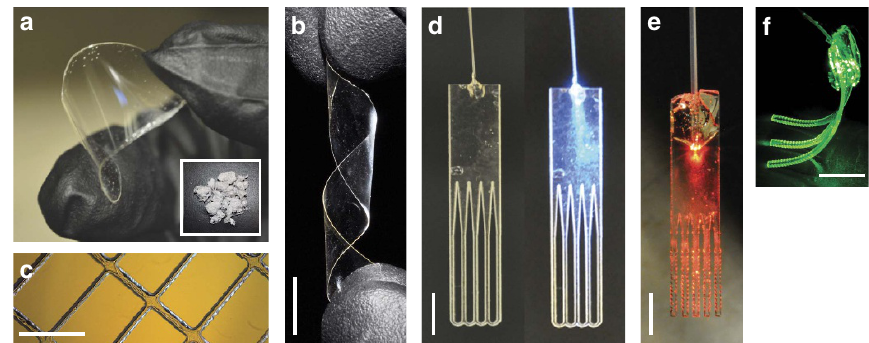
Figure 1 | Various biopolymer films and planar waveguide demonstrations. ( a ) Transparent and flexible poly( L -lactic acid) biopolymer film obtained by melt-pressing technique. Inset: biopolymers in their initial powder form before film formation. ( b ) A twisted bio-film before laser cutting. ( c ) Laser cutting allows for a simple fabrication of films with well-controlled meshes. ( d ) A fibre-coupled waveguide array with an unstructured top region uniformly coupling the light to the array of thin waveguides. Left, off state; right, light on. Only the lower part of the devices is to be embedded into tissue, the top structure including the pigtail fibre is cut off and removed after use. ( e ) Red light coupled to a waveguide array. ( f ) A polyethylene glycol hydrogel waveguide array carrying green laser light. Scale bars, 10mm.